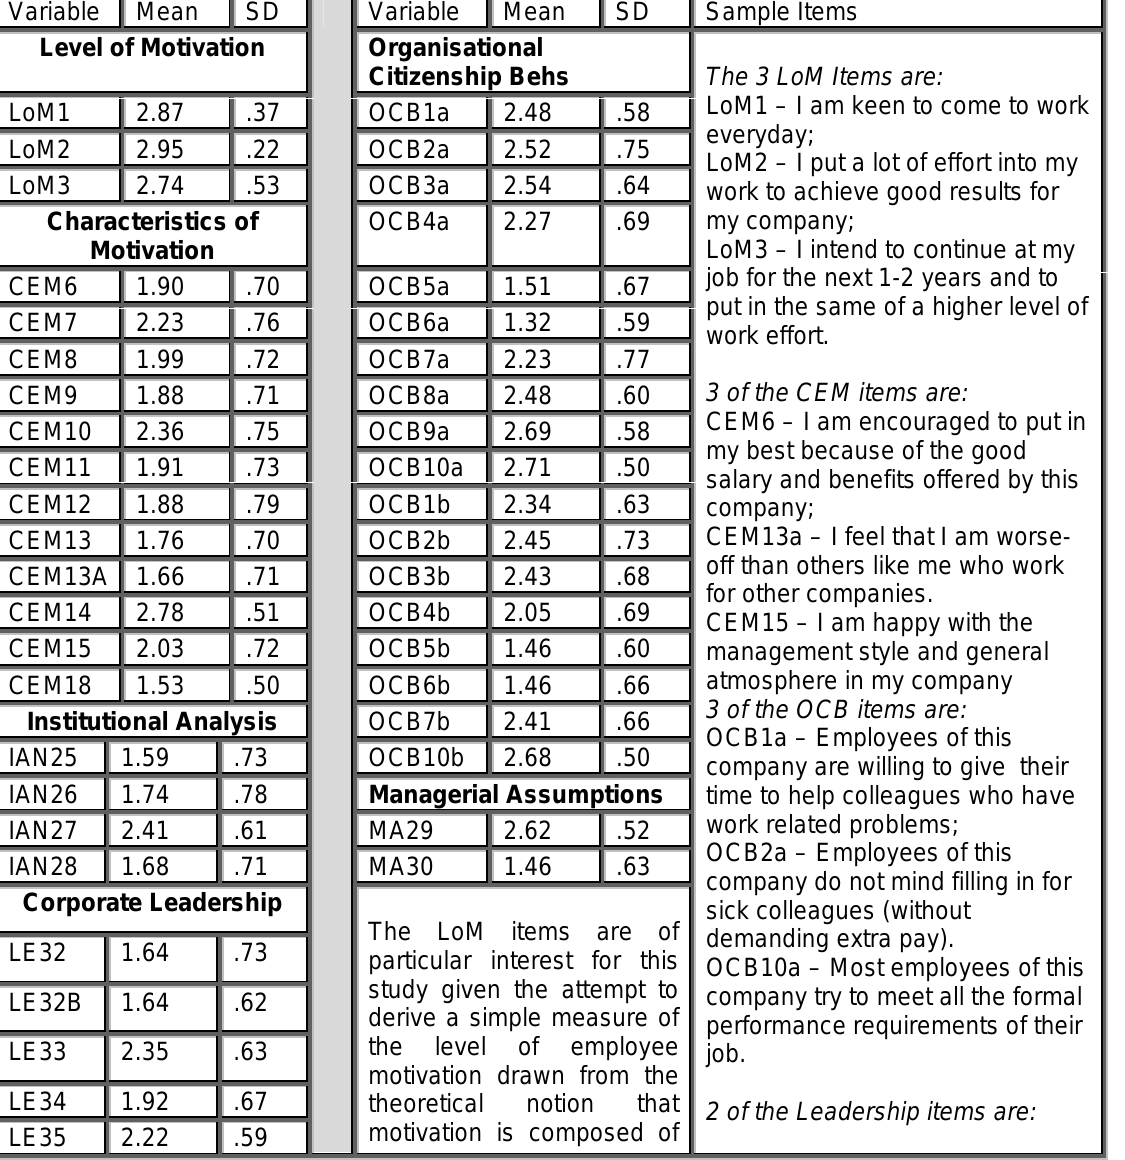
Table 3: Means across all variables